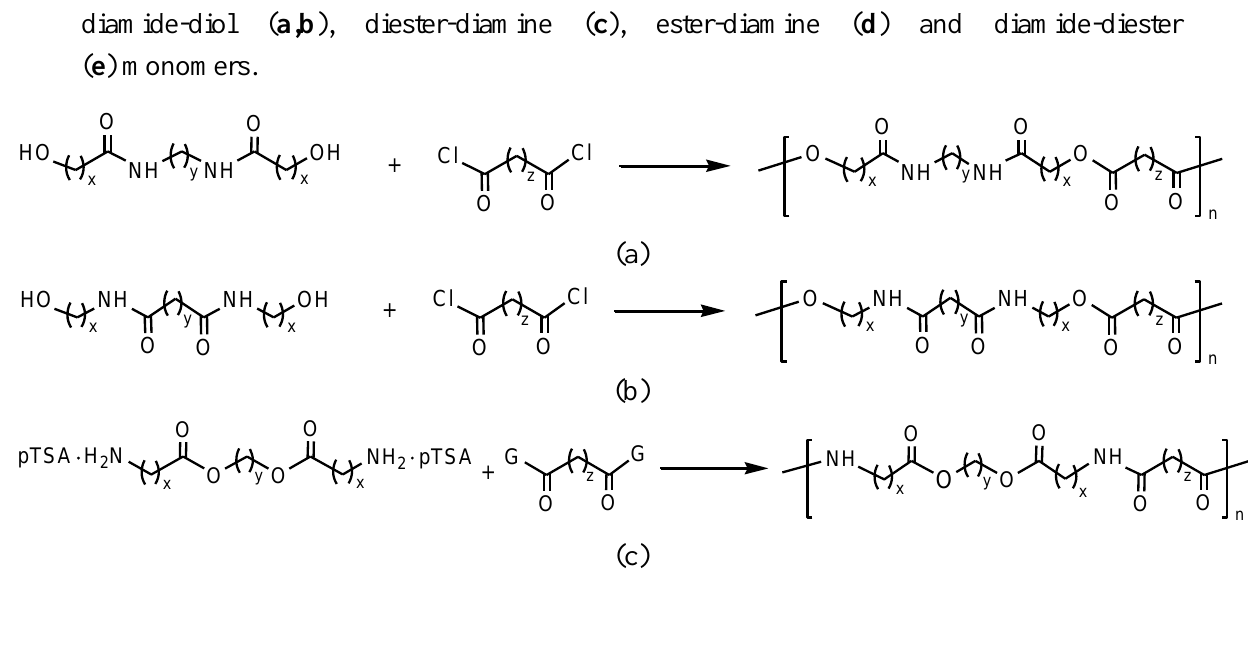
Figure 2. Examples of poly(ester amide)s prepared by polycondensation reactions of diamide-diol ( a,b ), diester-diamine ( c ), ester-diamine ( d ) and diamide-diester ( e )